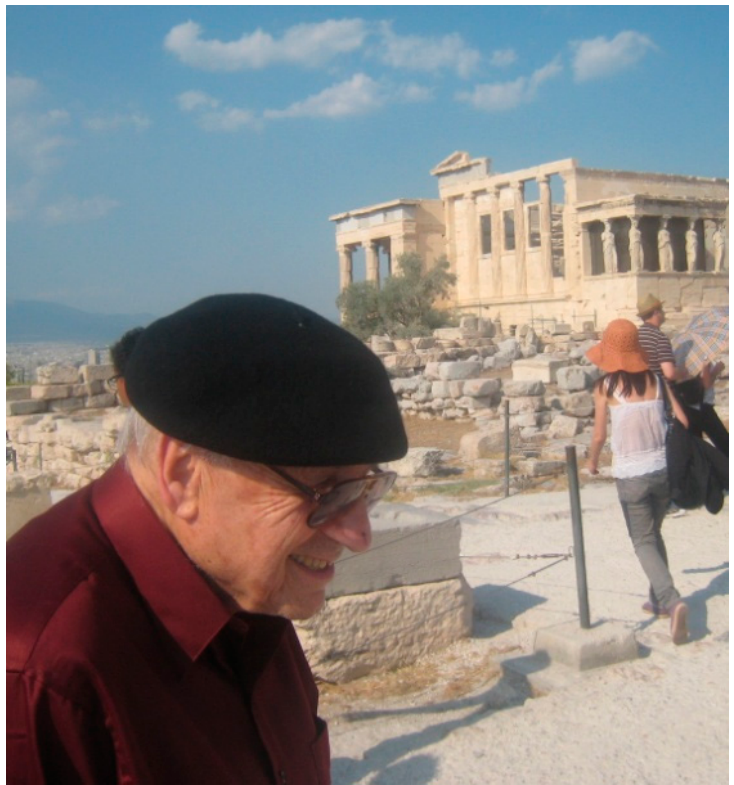
Figure 2. Walter Kohn at the excursion to Acropolis during the density functional theory (DFT) conference held in Athens in 2011.